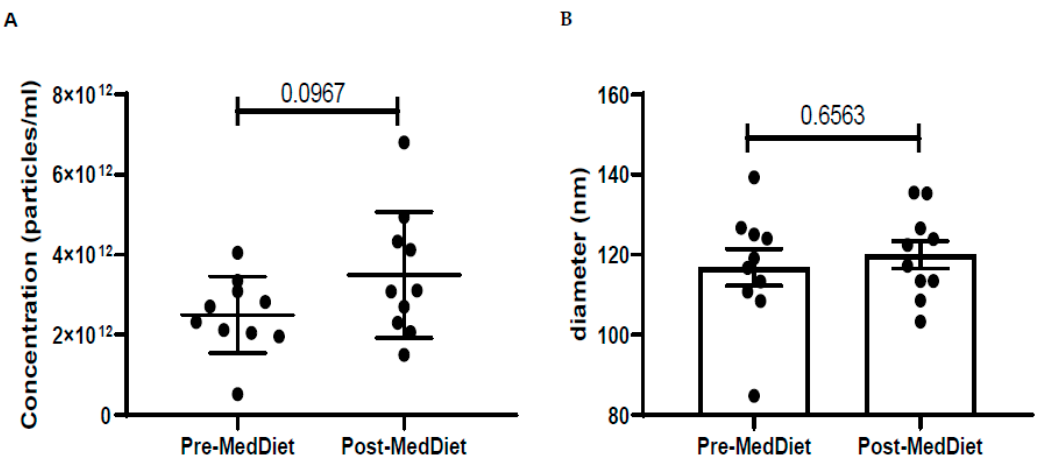
Figure A2. E ff ect of Mediterranean Diet on extracellular vesicles characteristics. ( A ) Concentration of plasma EVs between pre-MD and post-MD were compared, ( B ) Size of plasma EVs between pre- MD and post- MD were compared.